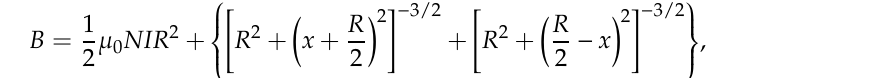
Table 2. Text documents recording the magnetic flux density and the Bx component of magnetic flux density of a certain individual in the population (5.txt was taken as an example and partial contents of 5.txt were shown).